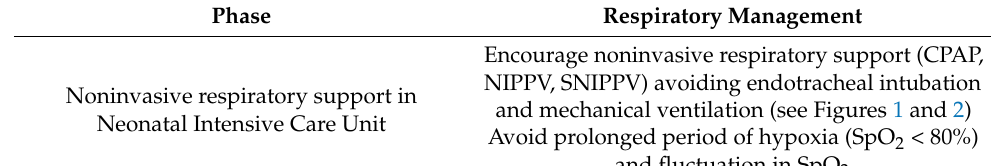
Table 3. Cont. Phase Respiratory